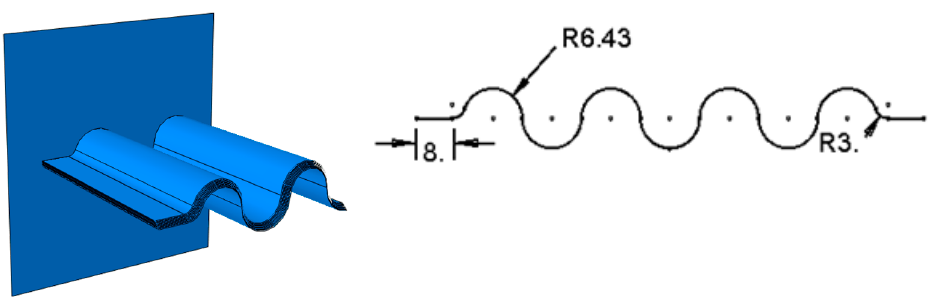
Figure 7. Abaqus/CAE model ( right ) and the schematic of the mid-plane of sinusoidal structures with 7 curvatures ( left ). (All dimensions are given in millimeters.)